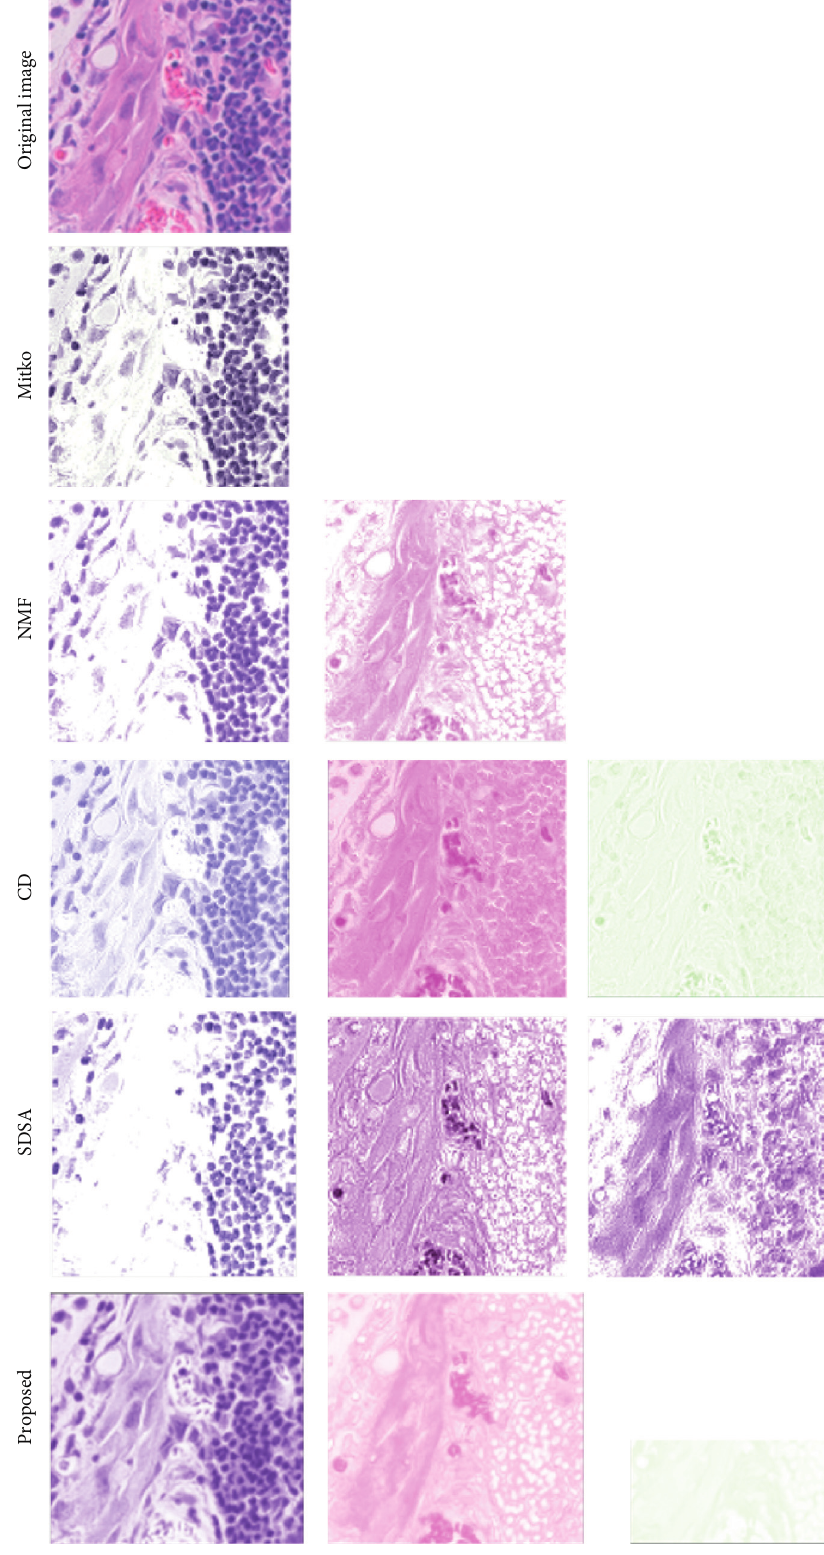
Figure 10: Comparison results against traditional